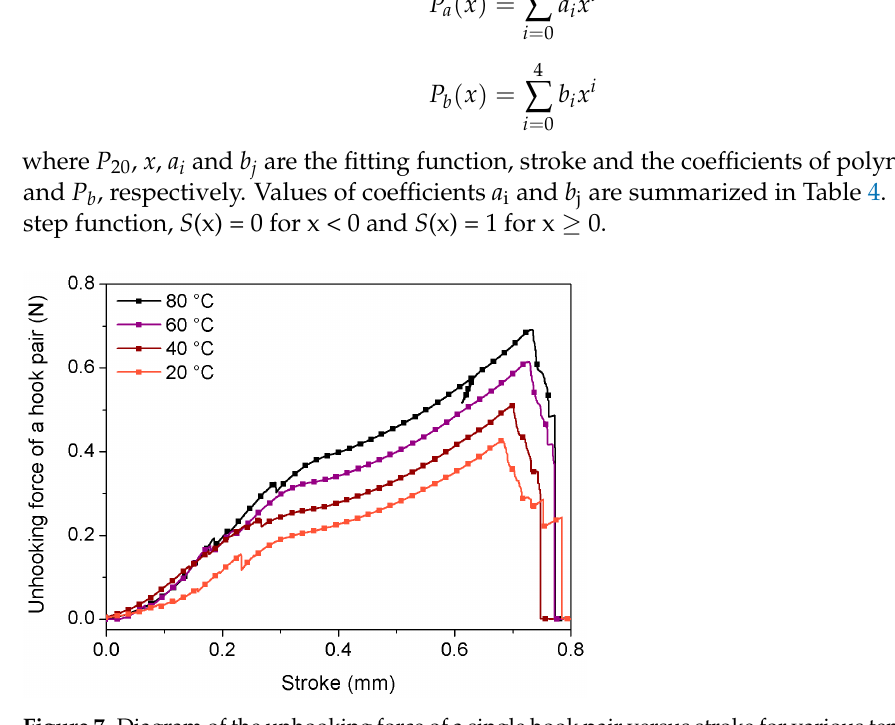
Figure 7. Diagram of the unhooking force of a single hook pair versus stroke for various temperatures. Table 4. Coefficients of polynomials P a and P b .